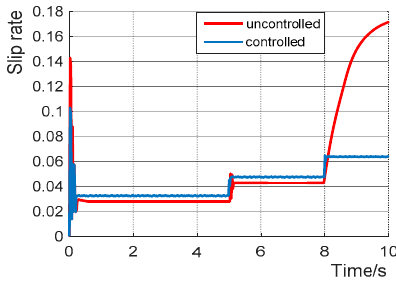
Figure 16. Slip rate curve.